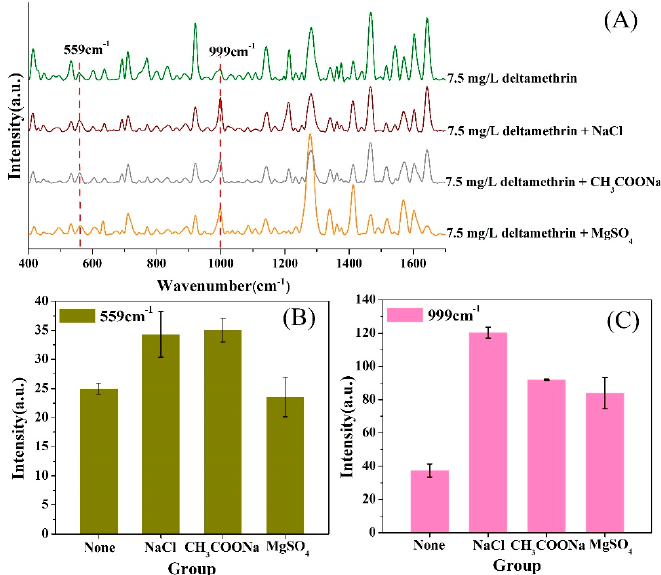
Figure 4. Comparison of water removal methods. ( A ) SERS spectra characters after removing water method by adding with sodium chloride, anhydrous sodium acetate and anhydrous magnesium sulfate. ( B ) peak intensity of 559 cm − 1 under di ff erent water removal modes; ( C ) peak intensity of 999 cm − 1 under di ff erent water removal